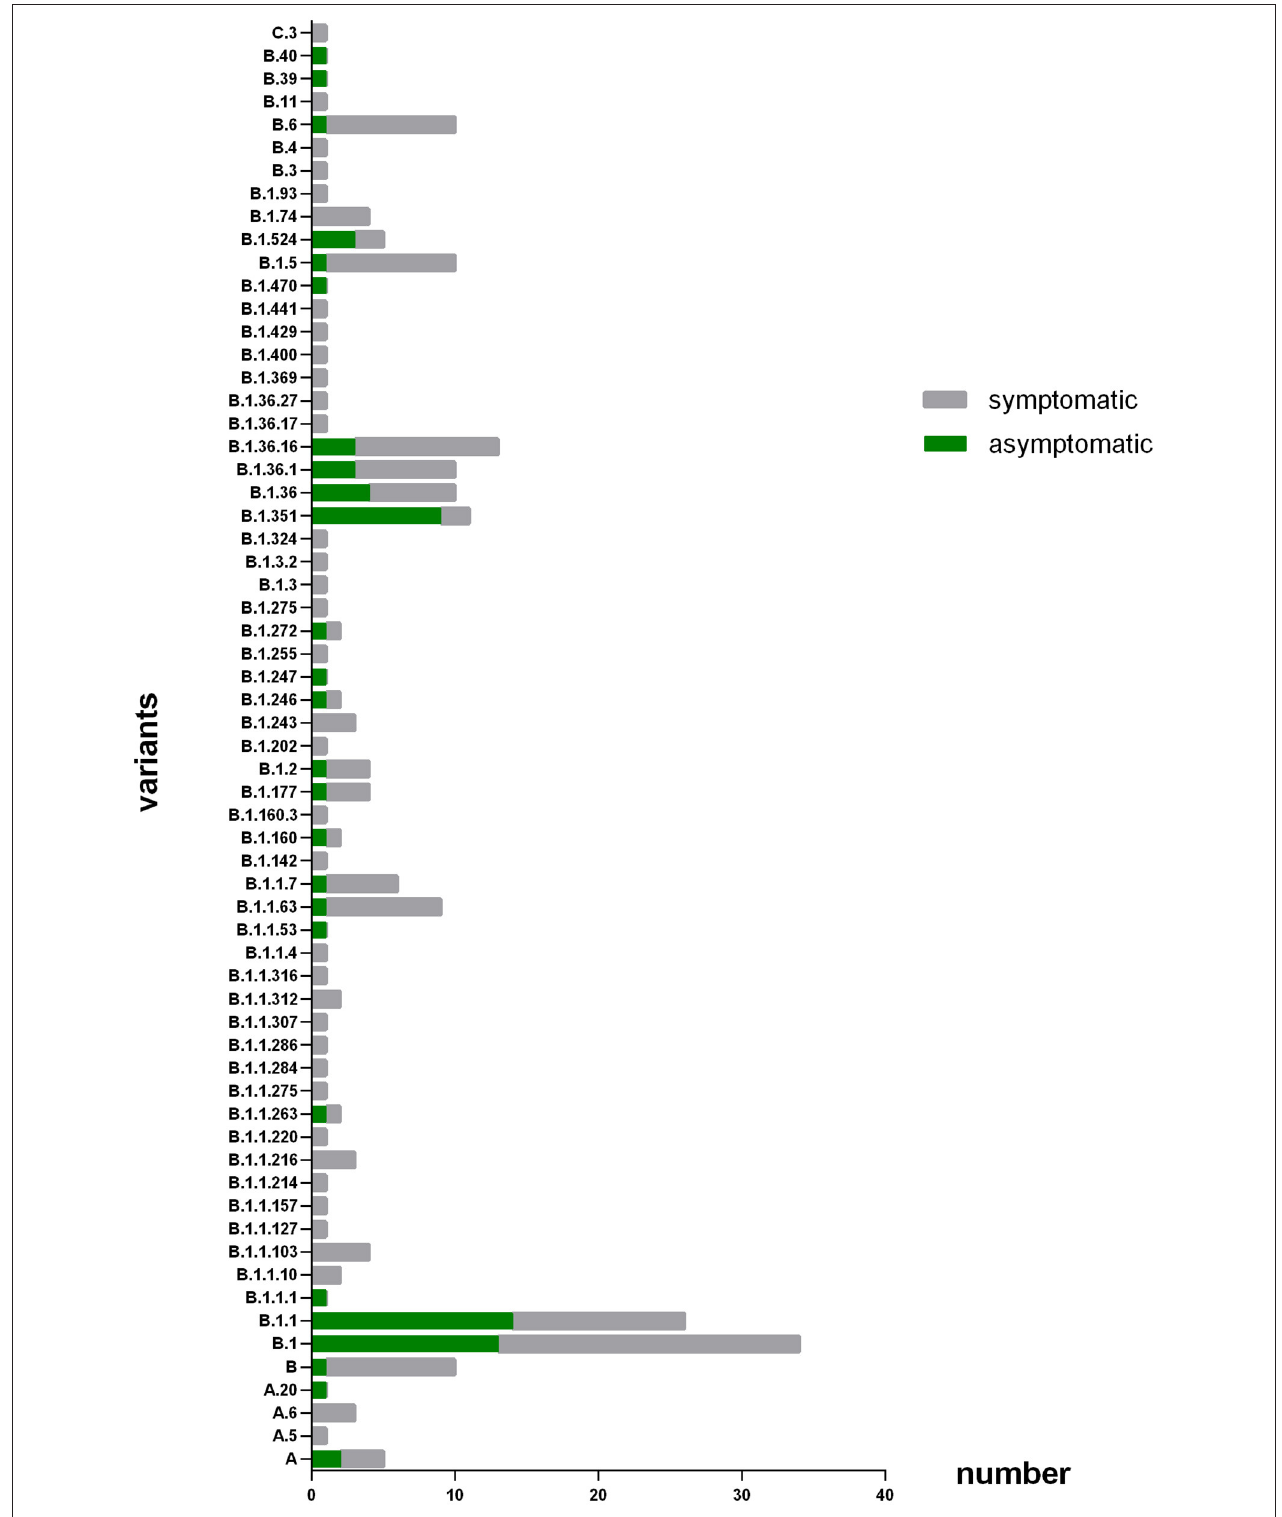
FIGURE 1 | Number of patients with different variants. The X axis refers to number of patients that infected with different subtype of virus; the Y axis refers to the different virus subtype that involved in this study. The coronavirus variants that patients enrolled in this study get infected major concentrated in B, B,1, B,1,1, B,1,1,63, B,1,1,7, B.1.351, B.1,36, B.1.36.1, B.1.36.16, B.15, B.1.524, and